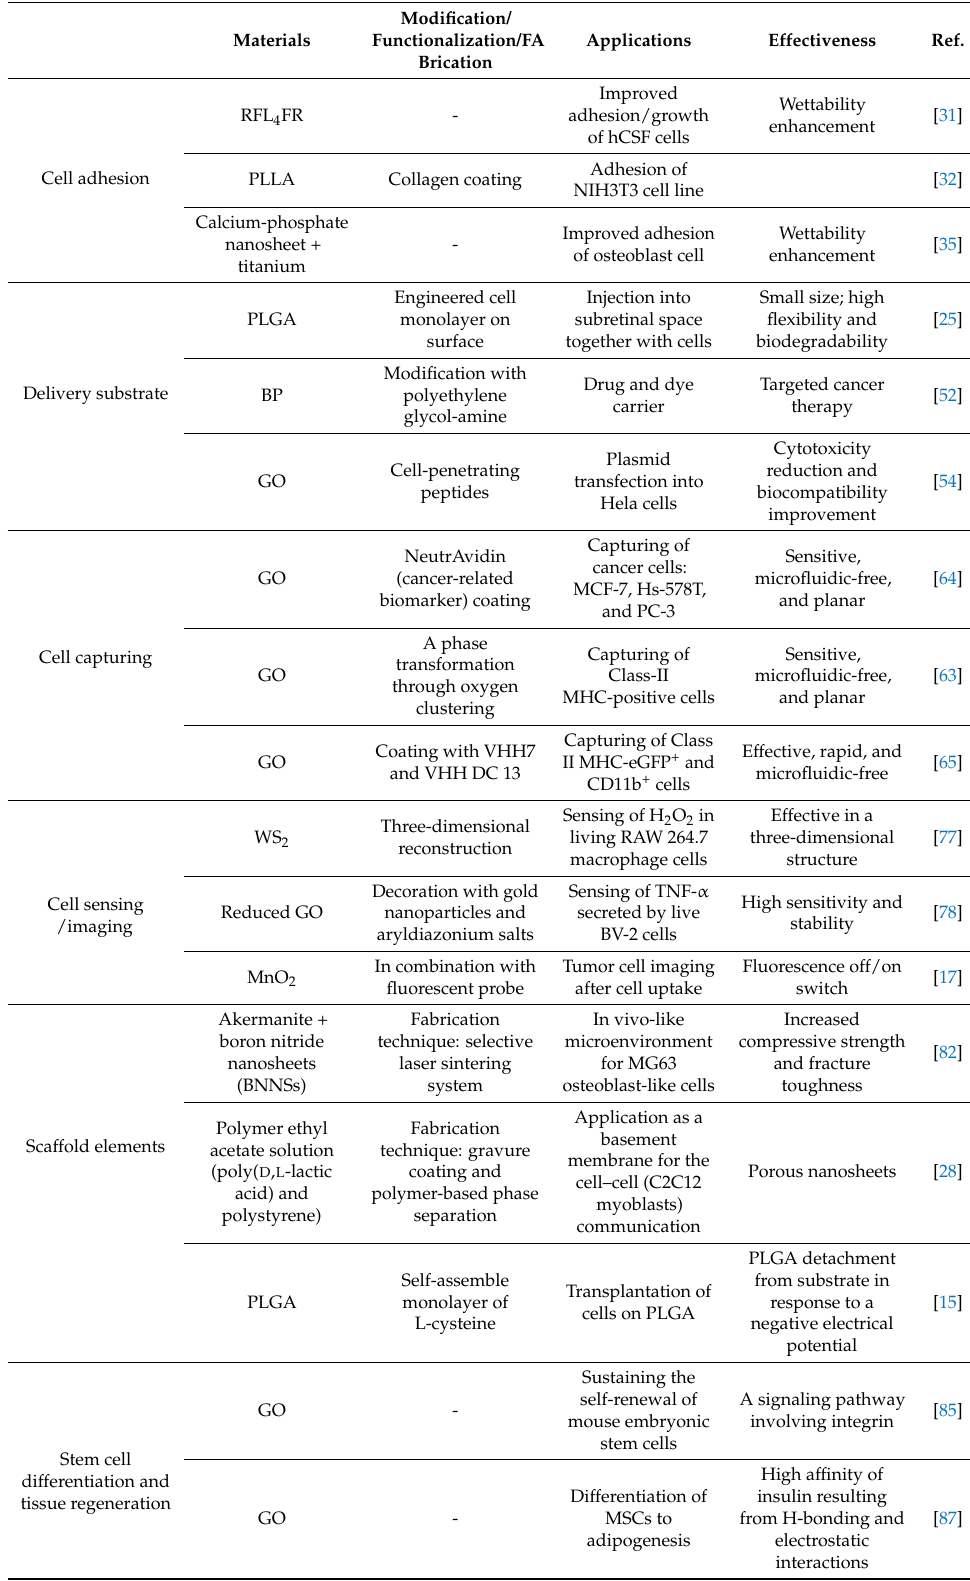
Table 1. Application examples of nanosheets in cellular research. PEG: polyethylene glycol; hCSF: human corneal stromal fibroblast; PLGA: poly(lactic- co -glycolic acid); BP: black phosphorus; MSC: marrow-derived mesenchymal stem